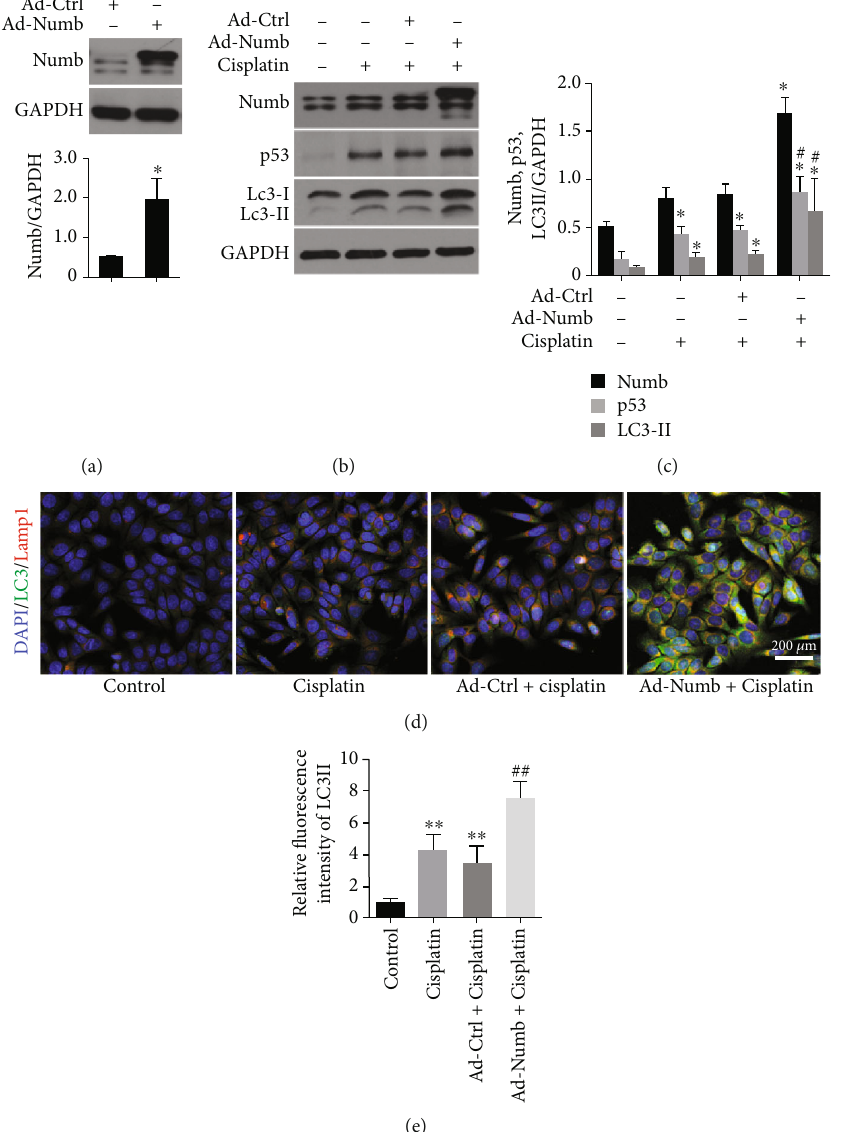
Figure 3: Overexpression Numb promotes autophagy in NRK-52E cells induced by Cisplatin. NRK-52E cells were infected with Ad-ctrl or Ad-Numb followed by treated with Cisplatin or vehicle (saline) for 6 hours. (a) The overexpression of Numb was con fi rmed using Western blotting assay. ∗ P < 0 : 05 versus cells treated with vehicle. (b) The protein expression of Numb, p53, and LC3-II in cells of di ff erent groups as indicated, GAPDH was used as loading control. (c) Relative expression of Numb, p53, and LC3-II to GAPDH was represented in graphic. (d) Representative immuno fl uorescence images of co-expression of LC3-II (green) and LAMP1 (red) in cells of di ff erent groups as indicated. Magni fi ed 400 times. (e) Quantitative statistics for immuno fl uorescence images. Data are shown as means ± SD of three independent experiments. ∗ P < 0 : 05 , ∗∗ P < 0 : 01 versus cells treated with saline-treated cells (Control). ∗ P < 0 : 05 versus vehicle-treated cells. # P < 0 : 05 , ## P < 0 : 01 versus Ad-Ctrl infected cells with Cisplatin treatment. Data are shown as means ± SD. n =3. ∗ P < 0 : 05 versus cells treated with saline